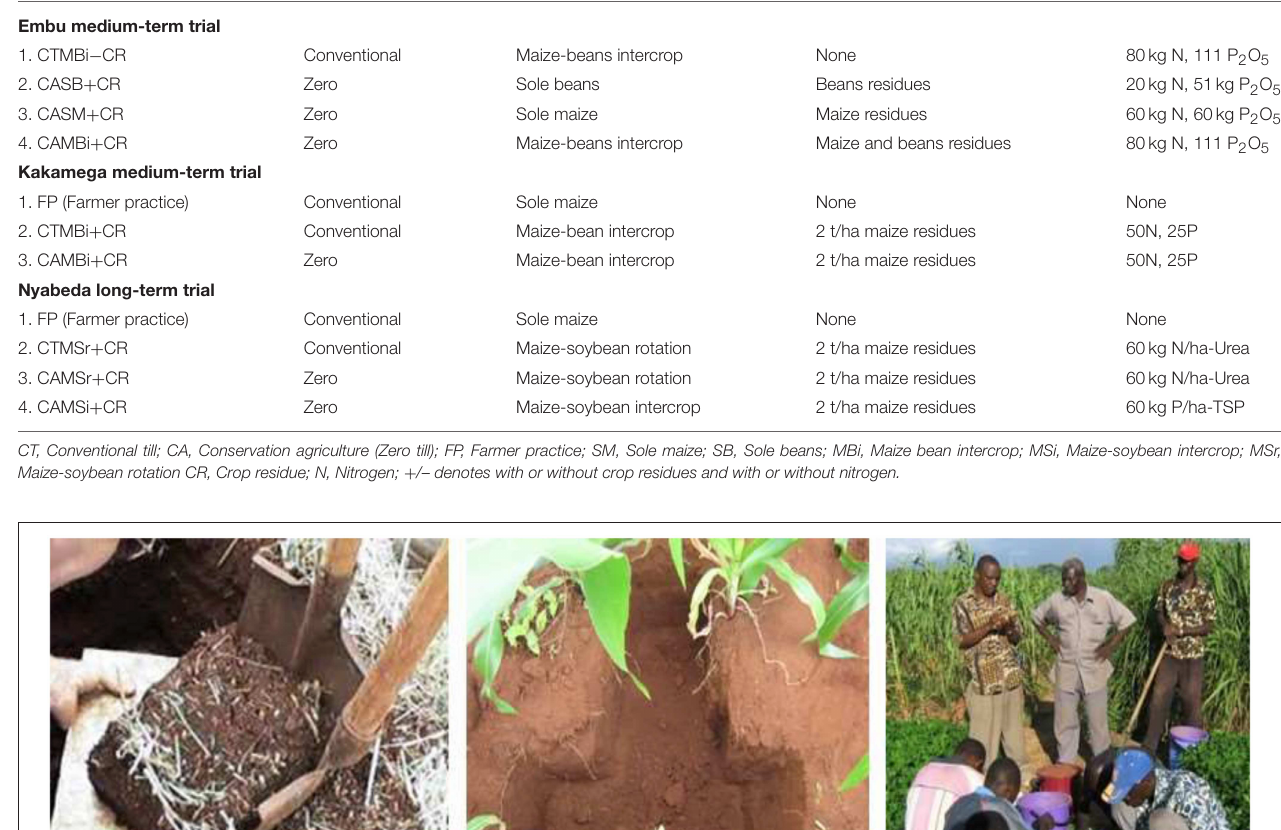
TABLE 2 | Treatment selected and descriptions. Treatment Tillage Cropping Organic